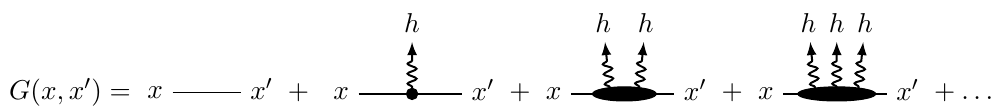
Figure 1. Graphical representation of the Green function G ( x, x 0 ) of eq. (2.16) for a massive scalar moving in a weak gravitational background g µν = η µν + κh µν , excluding the Rφ 2 interaction in eq. (2.8). A closed expression for the Green’s function in momentum space may be found in eq.